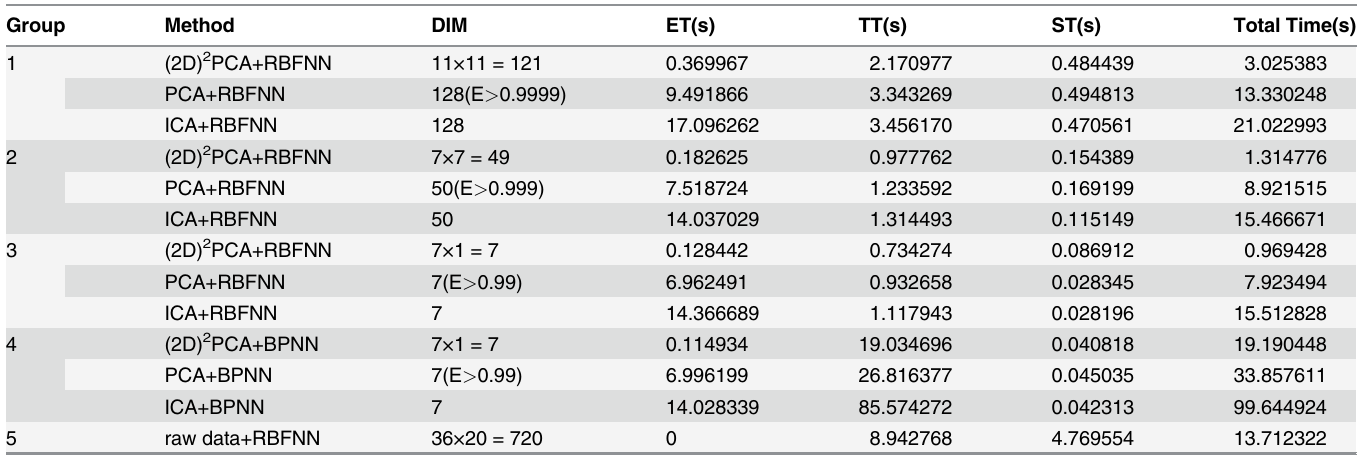
From Table 3, almost all the measure indicators of the (2D) 2 PCA model are superior to those of the PCA and ICA models. In the first group experiment especially, the (2D) 2 PCA model shows much better performance than the other models. For example, the indicators PCD, R 2 and HR of the (2D) 2 PCA model reach 0.75309, 0.99369 and 0.73251, respectively, which are much larger than those of the PCA and ICA models. From the indicators, only the PCD of the (2D) 2 PCA+RBFNN model is less than that of the ICA+RBFNN model when the dimension is 50, and the other 8 indicators are superior to the ICA+RBFNN model. Comparing the (2D) 2 PCA+BPNN model with the PCA+BPNN model and ICA+BPNN model, the (2D) 2 PCA +BPNN model shows better performance than the other two models, and the RMSE 29.215 of the (2D) 2 PCA+BPNN model is smaller than that of the PCA+BPNN model (35.819) and ICA +BPNN (80.51).